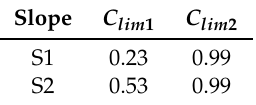
Table 5. Summary of PoF values obtained for the two water table conditions